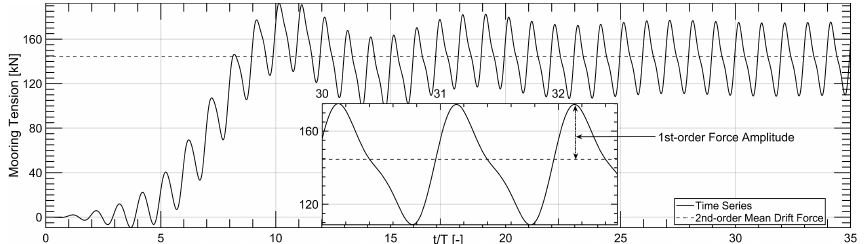
Figure 9. Sample time series of mooring tensions of the one-module case for the chain configuration.